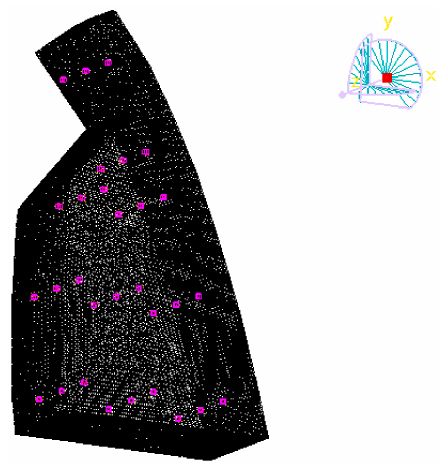
Figure 20. Layout of observation points of acoustic pressure in the cavity.